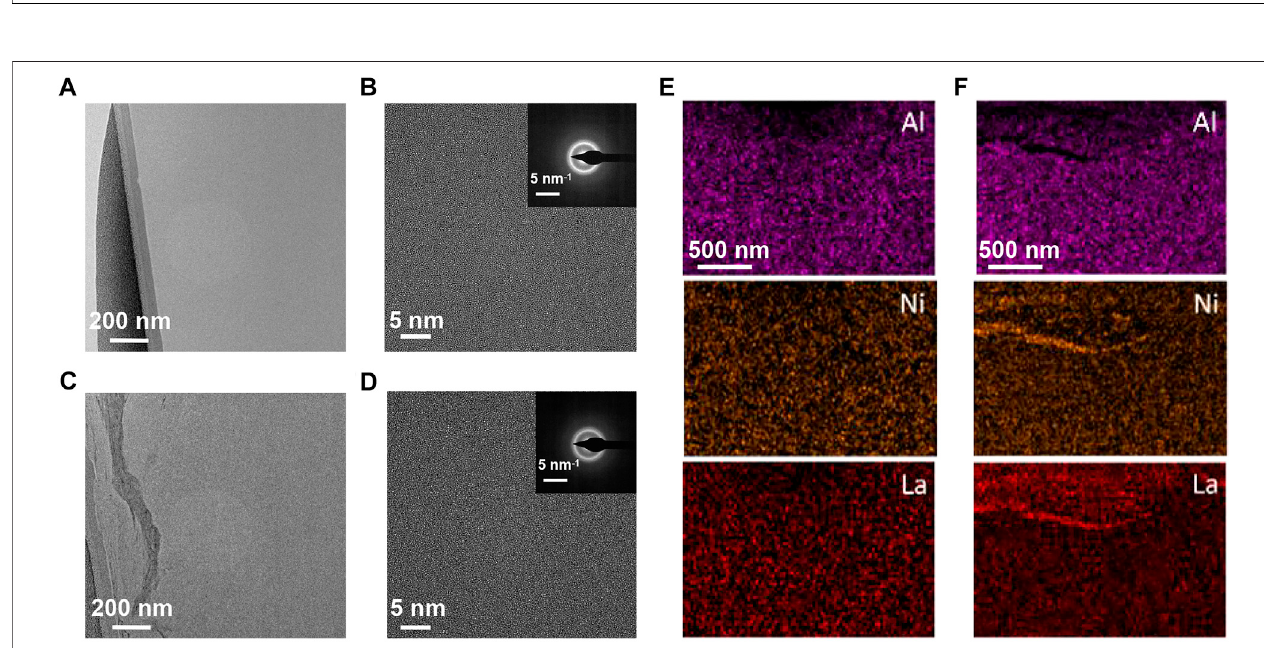
FIGURE4 | TEM and EDS patterns ofAl-based MG ribbons before and after UV. (A) Microscopic surface topographyof the amorphous alloy ribbons prepared by FIB. (B) High-resolutionatomicstructureandelementaldistributionsoftheamorphousalloyribbon.Theinsetshowsthecorrespondingselectedareaelectrondiffraction pattern. (E) Element Distribution in microregions of the amorphous alloy ribbon. (C) , (D) , and (F) Corresponding data of the amorphous alloy ribbon after UV.